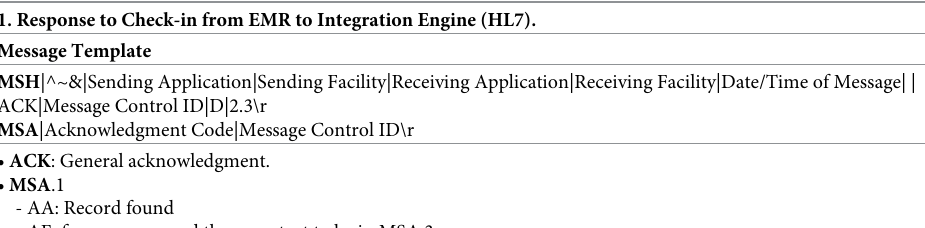
Table 4. Final step to acknowledge the success of “Check-in”